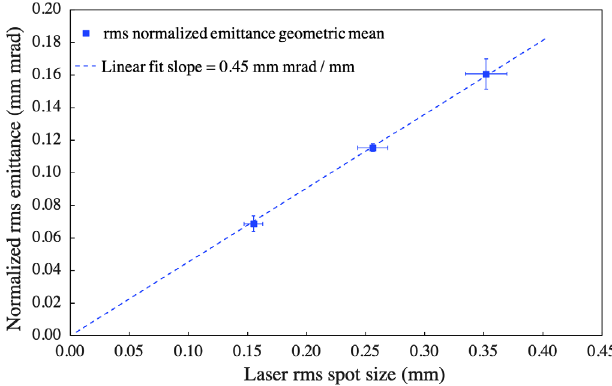
10. Normalized rms emittance vs laser rms spot size at the photocathode for laser wavelength 533 nm. From the linear curve fit slope, the thermal emittance is 0 . 45 (cid:2) 0 . 02 mm mrad =